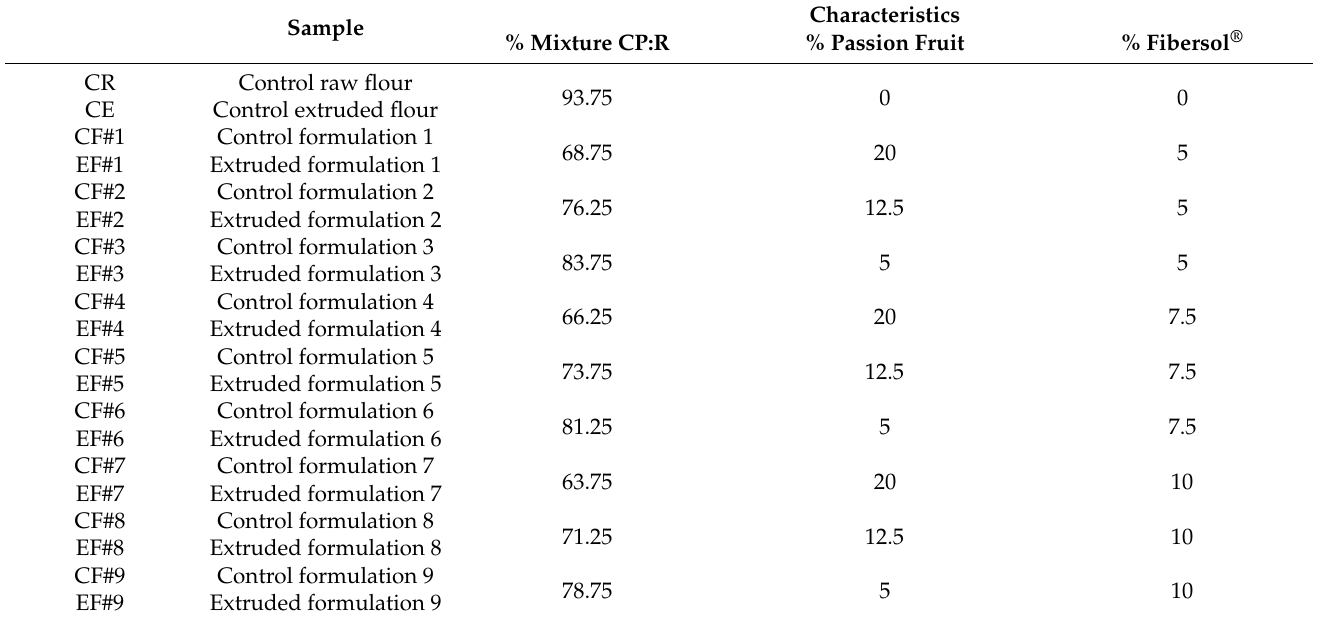
Table 4. Chickpea–rice flour formulations